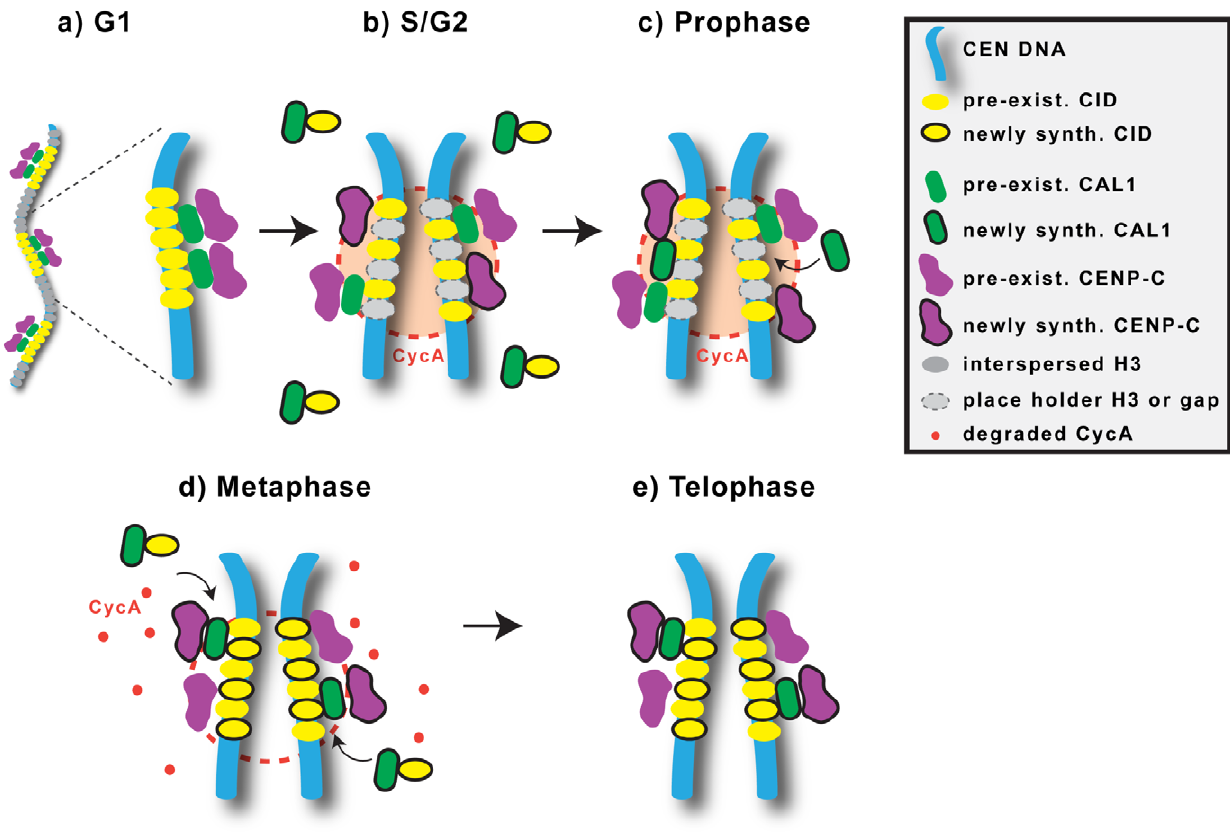
Figure 9. Model for centromere assembly in Drosophila cells. During the G1 phase of the cell cycle, the centromere contains the constitutive proteins CID, CENP-C and CAL1, which are reciprocally required for localization and interact physically. Blocks of CID nucleosomes (yellow) are interspersed with blocks of H3 nucleosomes (grey; not shown in zoom and subsequent phases for simplicity). Soluble CID is associated with CAL1. B) In S phase, centromeric DNA is replicated and, as a result, CID, CENP-C and CAL1 become diluted. Histone H3 may be deposited temporarily within CID blocks as a placeholder. Newly-synthesized CENP-C as well as pre-existing, soluble, CENP-C (not shown) are recruited to centromeres in interphase and mitosis (not shown). C) During prophase, free newly-synthesized CAL1 is deposited at centromeres, replenishing the diluted CAL1. CYCA is localized at centromeres throughout the cell cycle, and could prevent deposition of new CID until metaphase. D) During metaphase, CYCA is degraded, an event that promotes incorporation of new CID, pre-existing CAL1 dissociates from the centromere, and newly-synthesized CID is recruited at centromeres possibly by delivery through CAL1. E) In telophase, the levels of CAL1 increase again, by addition of pre-existing CAL1 at the sites left open by its dissociation during metaphase. Reduced levels of total CAL1 in metaphase may be required to ensure that the correct amount of CID is deposited [25].